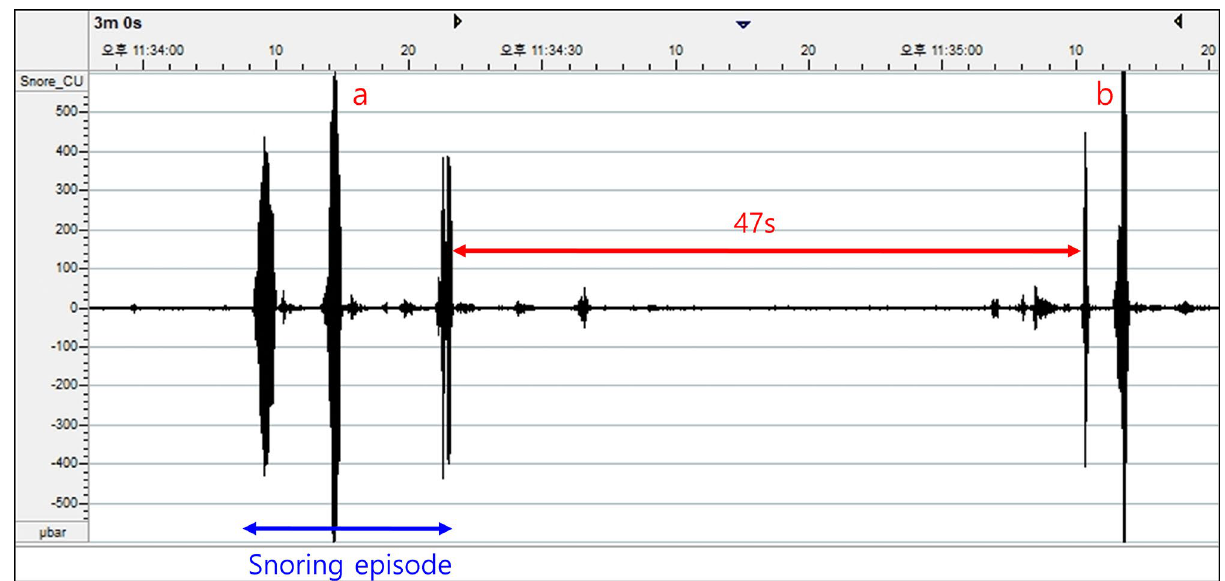
Figure 1. Definitions of a snoring event and snoring episode. When the pressure in the nasal airflow transducer is ≥ 200 microbar, the breath is classified as a snoring event. When there are 3 or more consecutive snoring events, it is defined as one snoring episode as shown in “a”. When 2 consecutive snoring events are separated from each other by > 10 s, they are not counted in the same snoring episode as shown in “b”. The values on the x-axis are in seconds and those on the y-axis are in